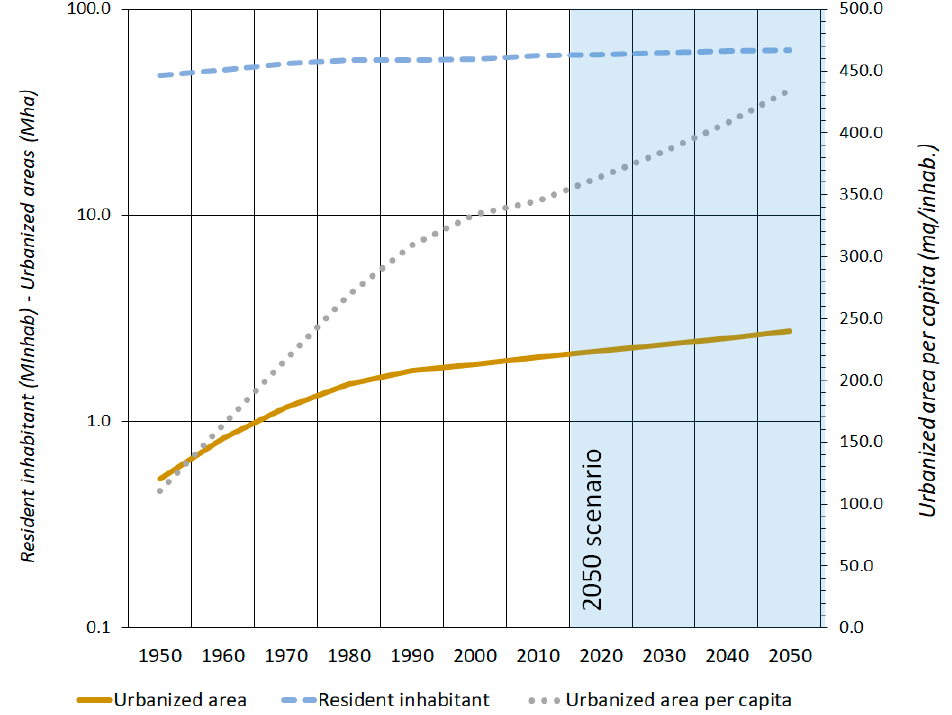
Figure 7. The curves show the comparison between population and urbanization dynamics against per capita urbanization in the periods analyzed and in the 2050 scenario.